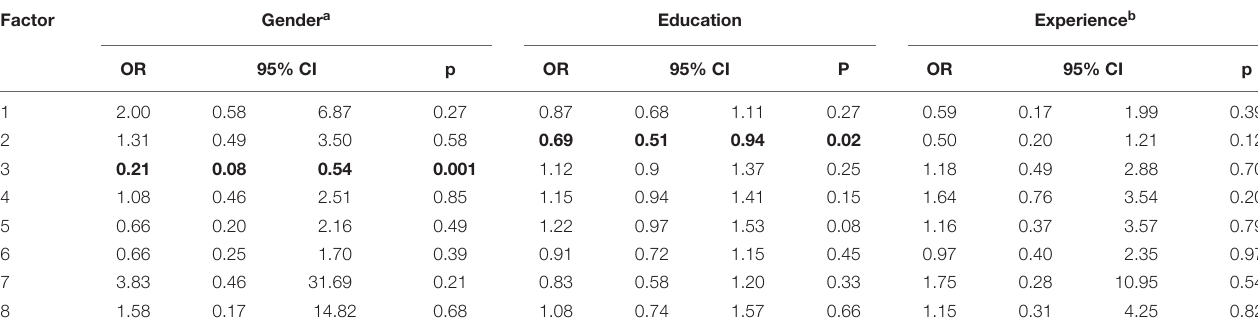
TABLE 4 | Association between the content factors of the mechanisms of change and therapists’ characteristics. Factor Gender a Education Experience b